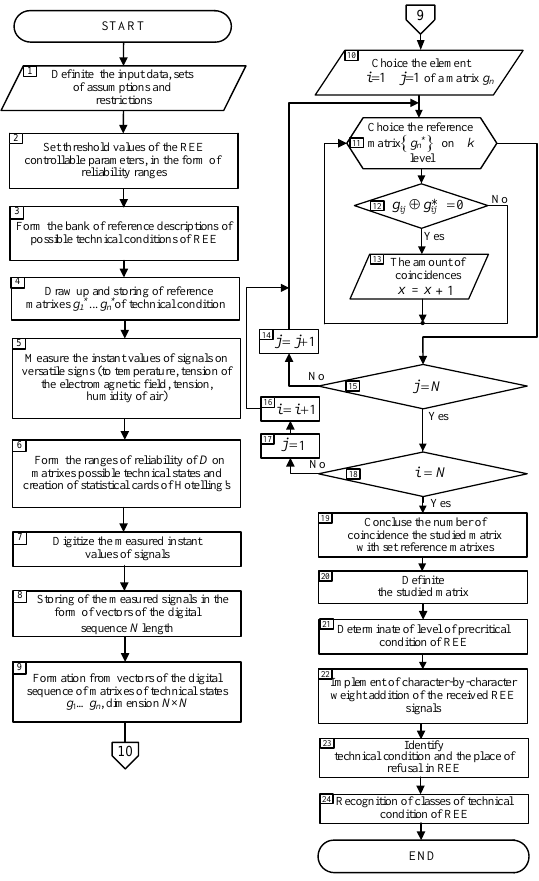
Fig. 2. The algorithm of integrated statistical control of technical condition in overall approach of REE